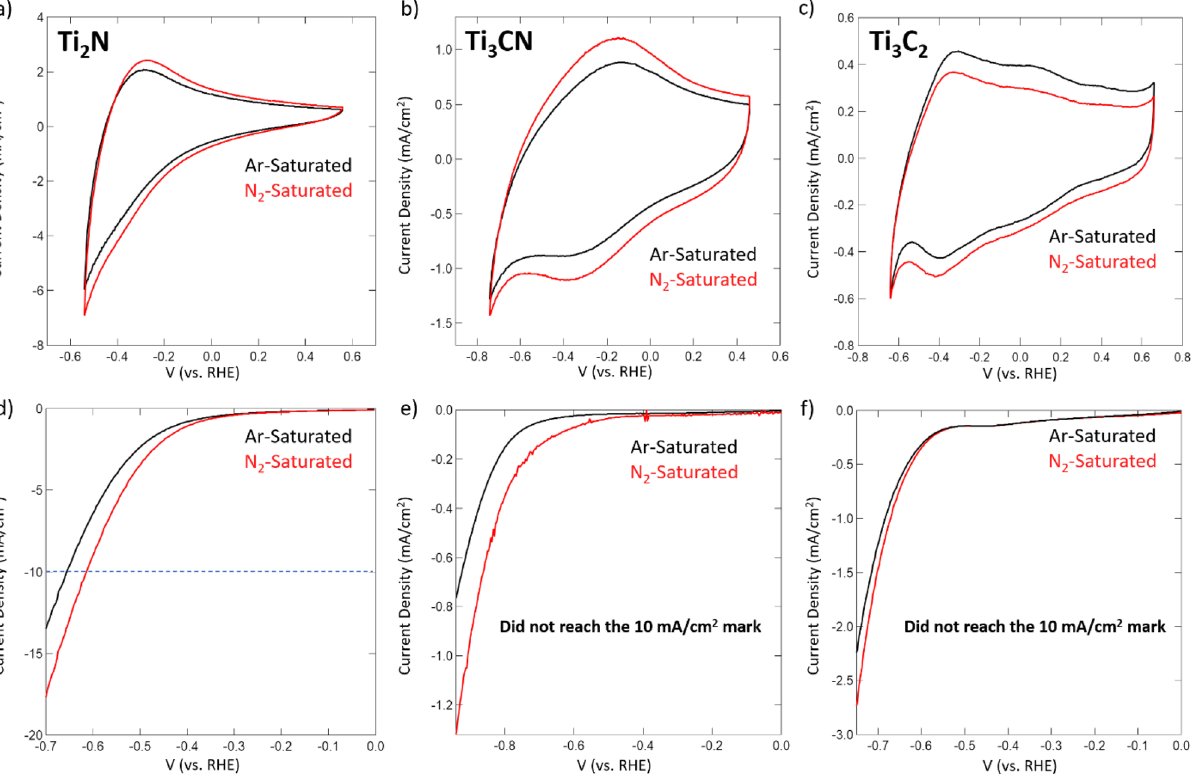
Figure 2. Cyclic voltammograms for ( a ) Ti 2 N, ( b ) Ti 3 CN, and ( c ) Ti 3 C 2 MXenes conducted in Ar-saturated (black) and N 2 -saturated (red) 0.1 M HCl electrolyte. All scans conducted using a scan rate of 20 mV/s. Linear sweep voltammograms for ( d ) Ti 2 N, ( e ) Ti 3 CN, and ( f ) Ti 3 C 2 MXenes conducted in Ar-saturated (black) and N 2 -saturated (red) 0.1 M HCl electrolyte. All scans conducted using a scan rate of 5